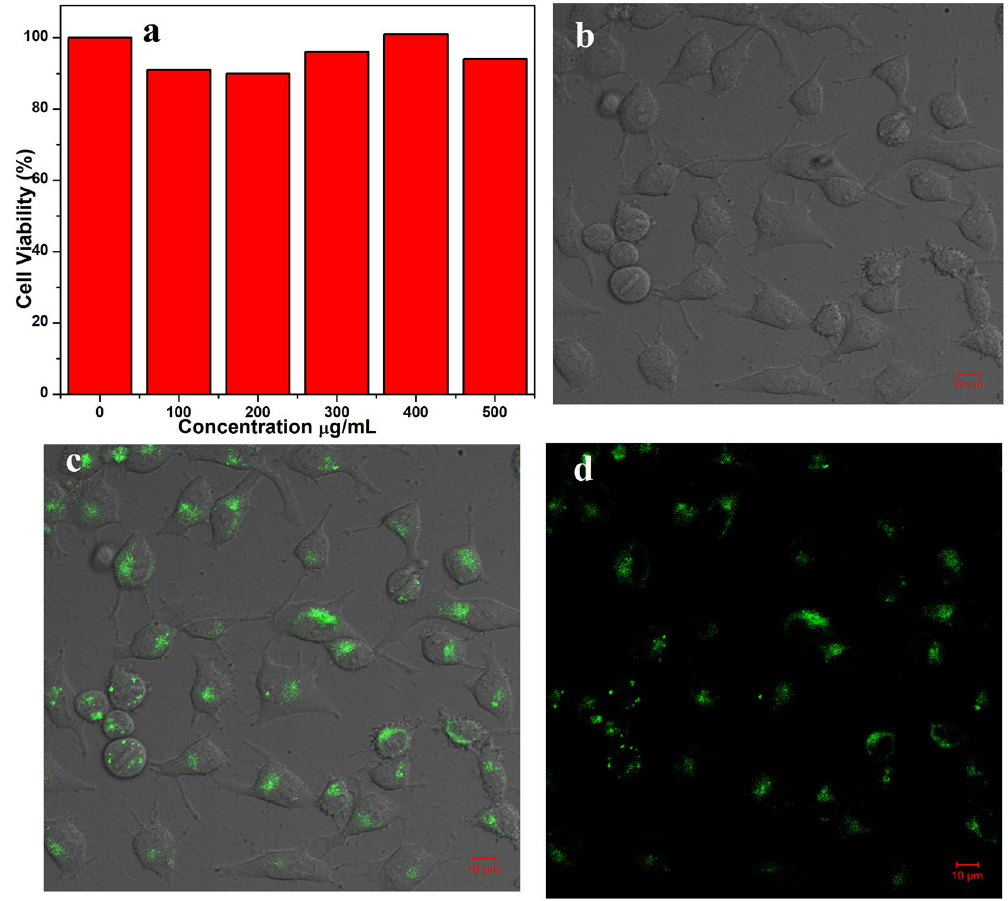
Figure 7. ( a ) Cellular toxicity assessment of green-emitting CDs. ( b ) Bright field image ( c and d ) Confocal fluorescent images of the green-emitting CDs under 405 nm laser